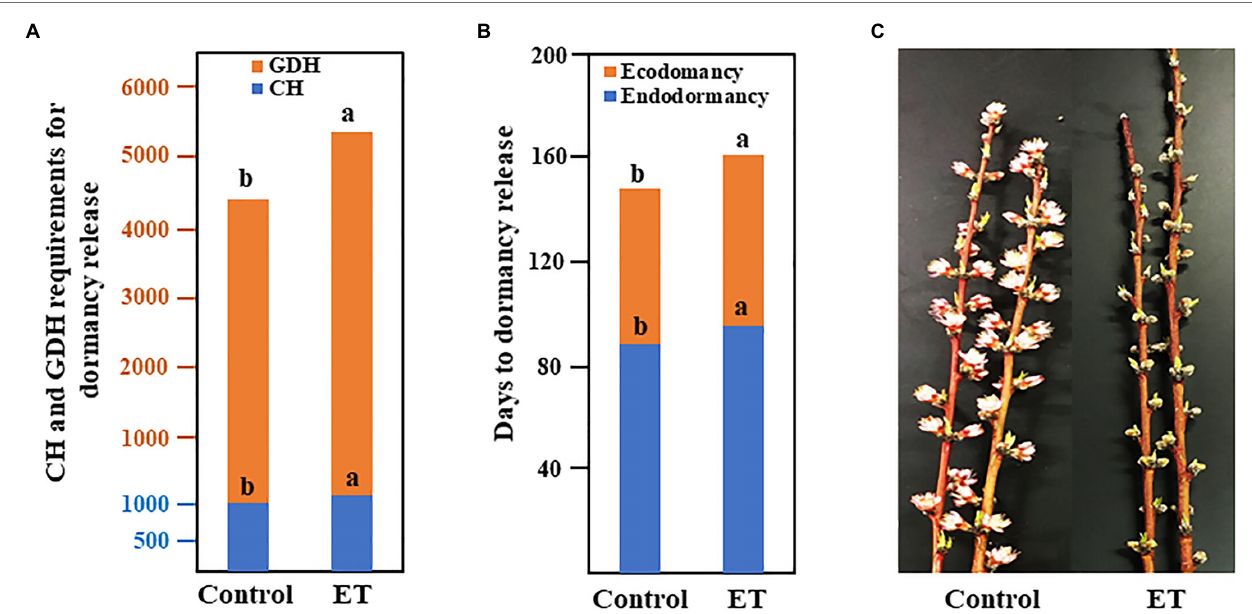
FIGURE 1 | Chilling and heat requirements (A) , duration of the endo- and ecodormancy (B) , and bloom delaying effects (C) of ethephon (ET) in peach “Red haven.” Data represent the mean of the three independent replicates. Bars labeled with different letters are significantly different at p < 0.05, according to Tukey’s HSD